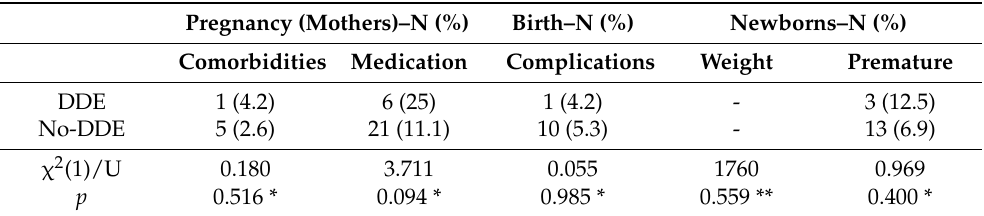
Table 2. Statistical comparisons between DDE and no-DDE groups regarding parameters related to mothers’ status during pregnancy and newborns.